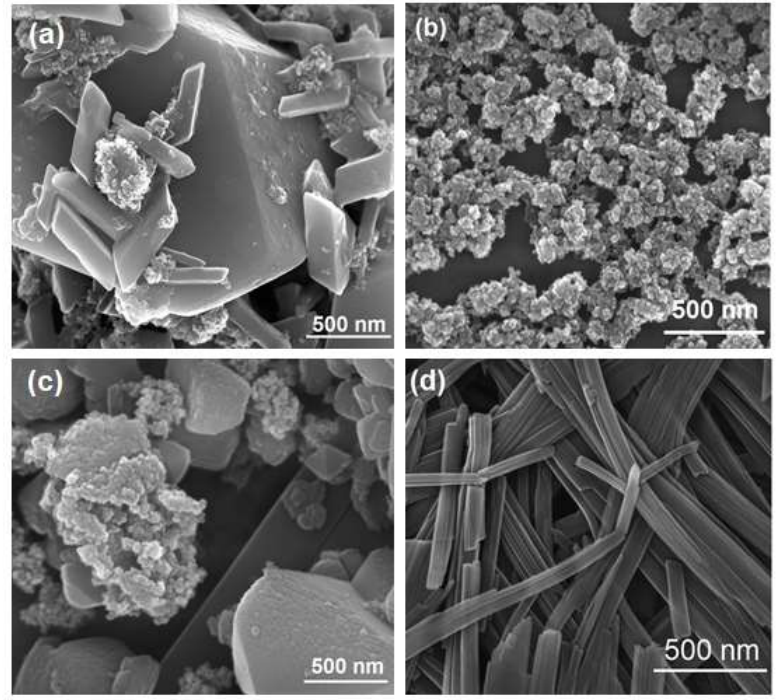
Figure 3. FE-SEM images for the assembly patterns of triads: ( a ) 1 ; ( b ) 2 ; ( c ) 3 ; ( d ) 4 .